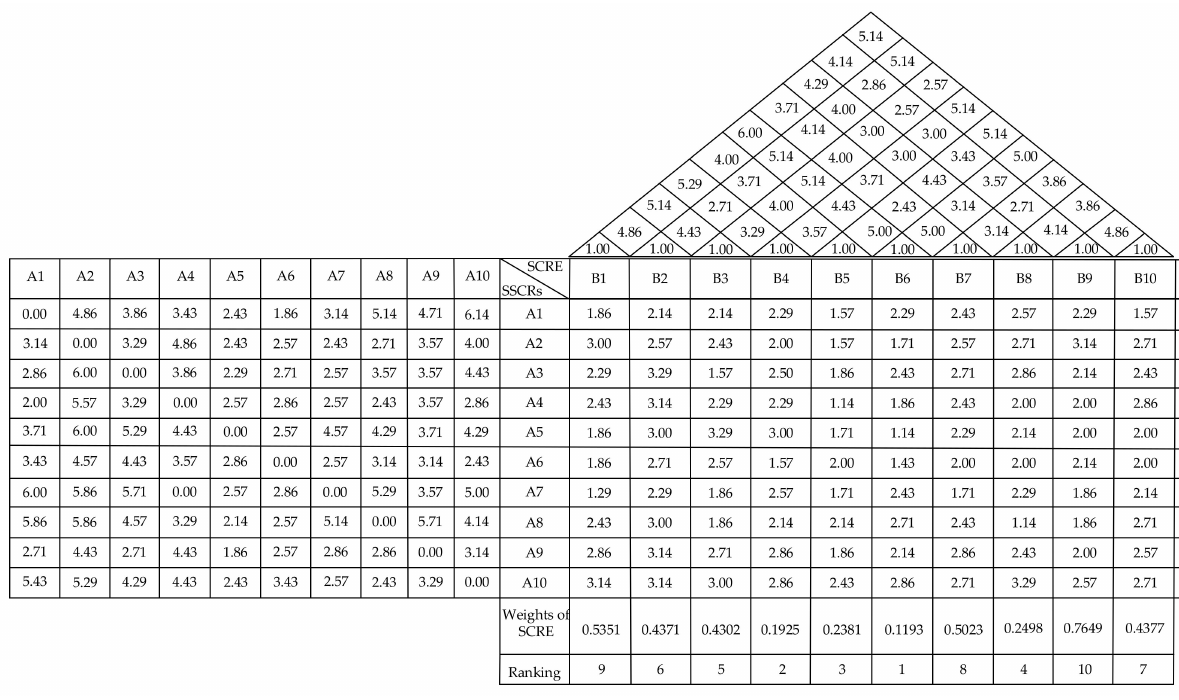
Figure 3. The first stage of HoQ. Table 10. Association matrix of resilience indexes. (B ×